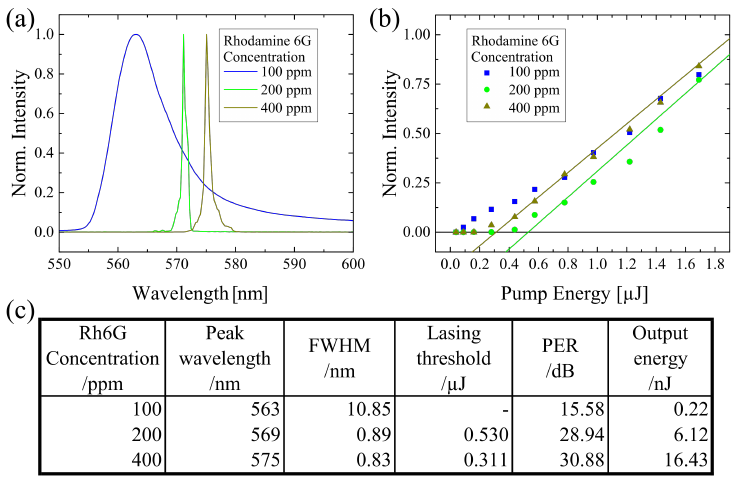
Figure 3. By using different Rhodamine 6G concentrations (100 ppm, 200 ppm, and 400 ppm), ( a ) the lasing spectra and ( b ) the lasing threshold were determined. ( c ) A table was presented to provide an overview of the lasing properties under the influence of Rhodamine 6G concentration